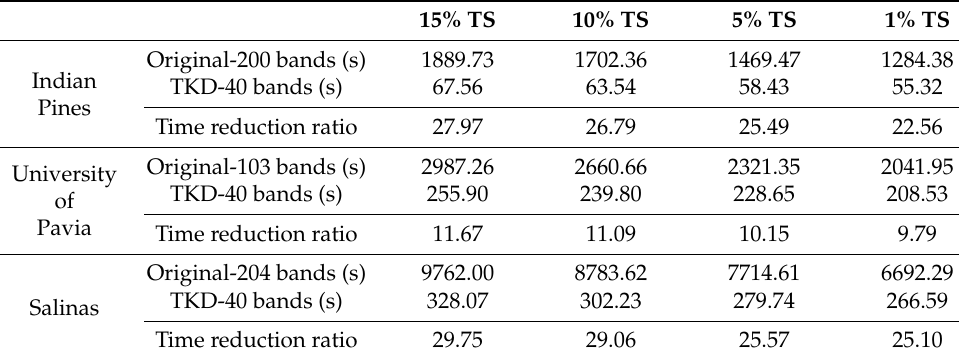
Table 10. Training time comparison for IP, UP, and SAL